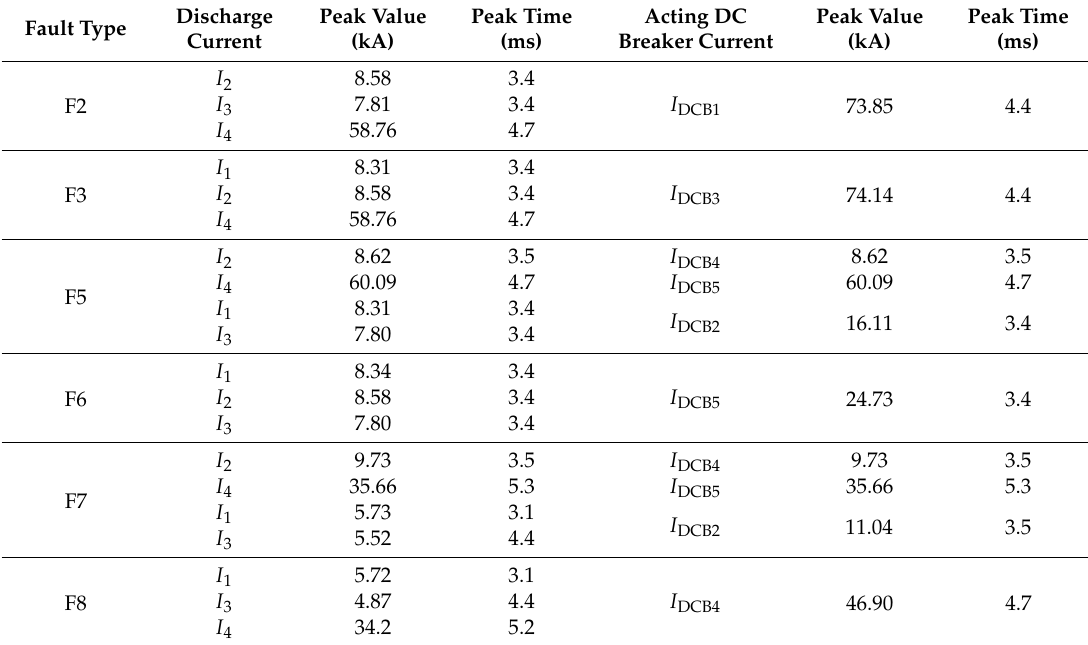
Table 4. Theoretical calculation results of DC breaker fault current.